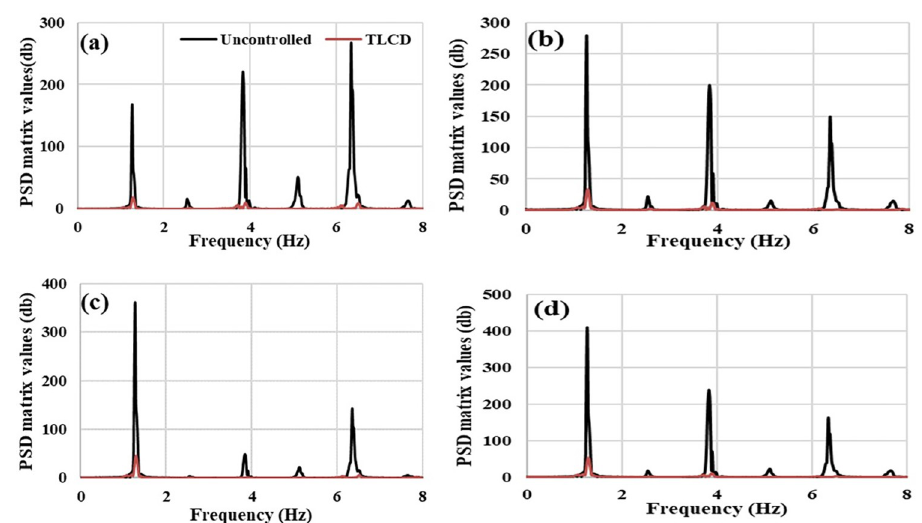
Fig 13. Acceleration power spectral density (PSD) responses of the MDOF structure equipped with and without TLCD at resonant loading, (a) Storey Level -01, (b) Storey Level -02, (c) Storey Level -03, (d) Storey Level -04.